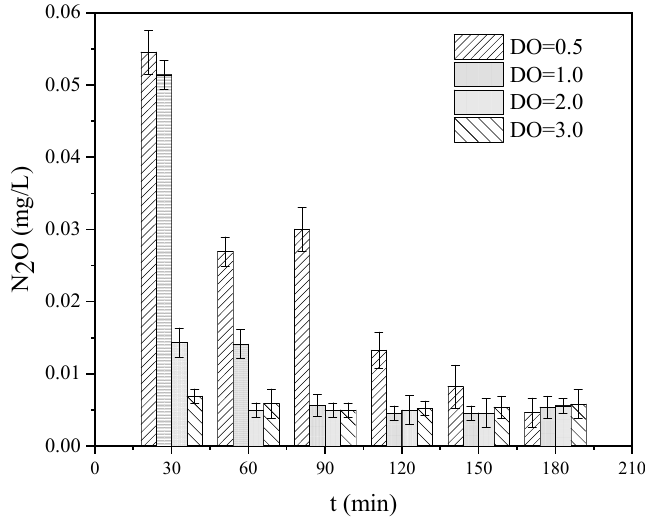
Figure 4. N 2 O emission during full nitrification (full nitrification effluent +NaNO 2 -N 20